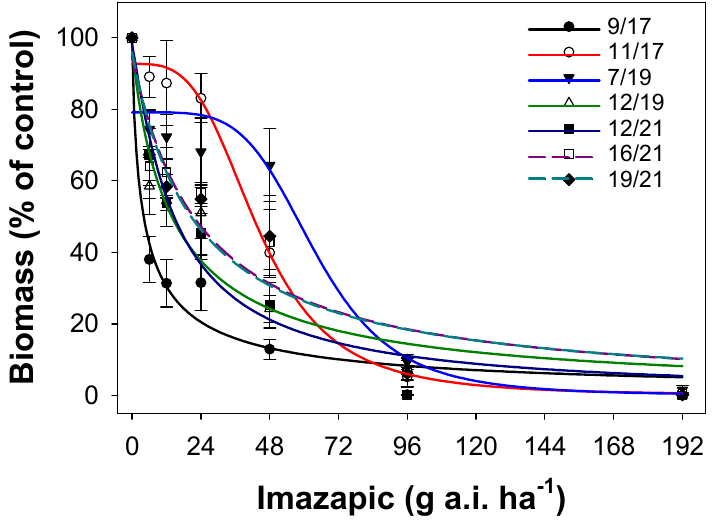
Figure 6. Effect of imazapic dose on biomass (percent of control) of seven populations of Chloris virgata . The most susceptible population was 9/17. Plants were sprayed at the four–five leaf stage of each population. Table 3. Estimated imazapic doses to kill 50% of the plants (LD 50 ) of seven populations of Chloris virgata , imazapic doses required to reduce plant biomass by 50% (GR 50 ), and resistance indices (RI). Population